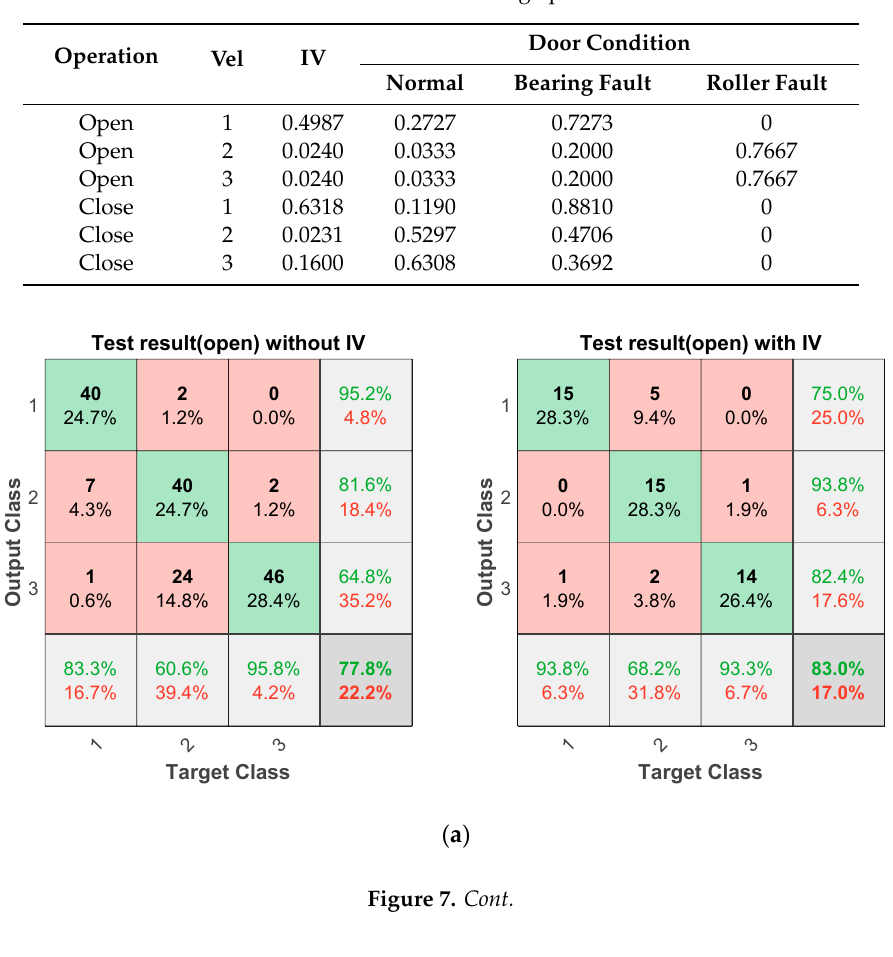
( b ) ( c ) Figure 7. Comparison of fault diagnostic results before and after applying information value: ( a ) open operation; ( b ) close operation; ( c ) open & close